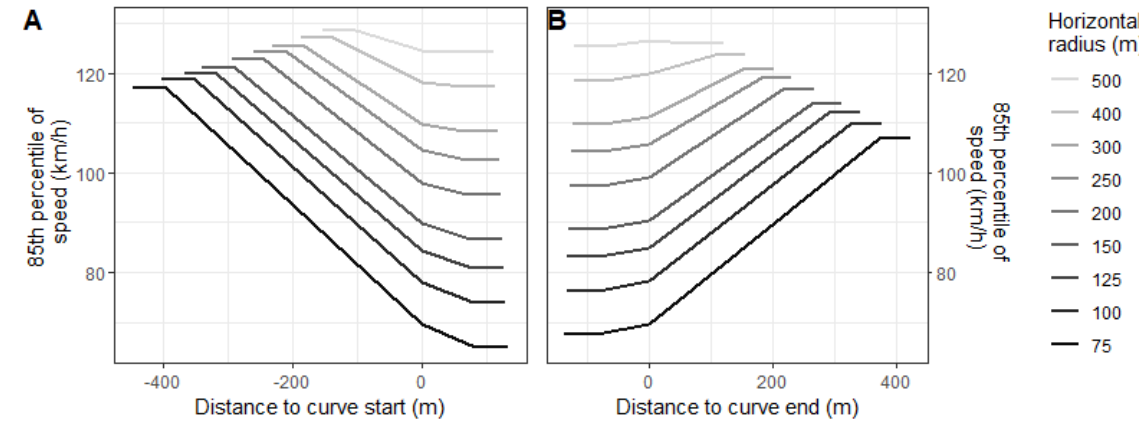
Figure 6. Profiles for the 85 th percentile of speeds on different horizontal radii based on breakpoints and related to the start and end of the curve.